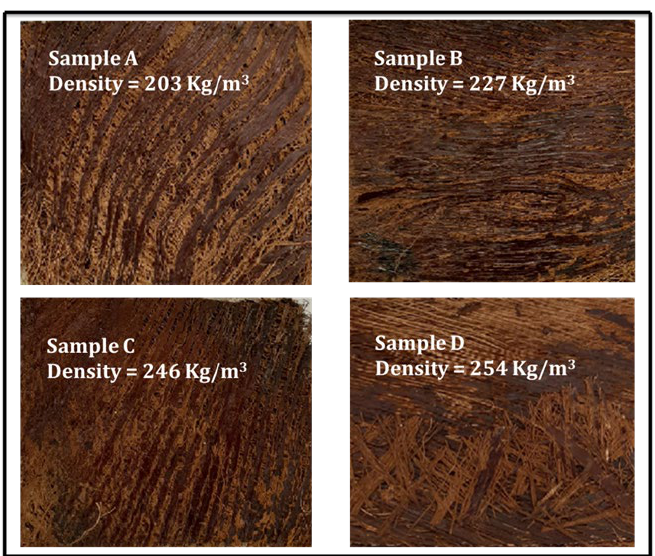
Figure 3. Images of the prepared DPSF/PVA insulation composites varying in density (four samples).